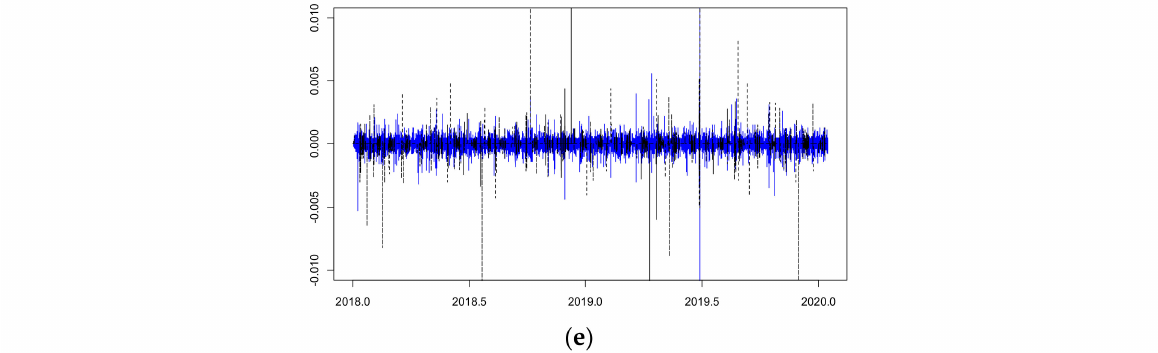
Figure 1. Spot (blue line) and future (black dotted line) 5-min return plots: ( a ) CAD-5 min, ( b ) CNY-5 min, ( c ) EUR-5 min,